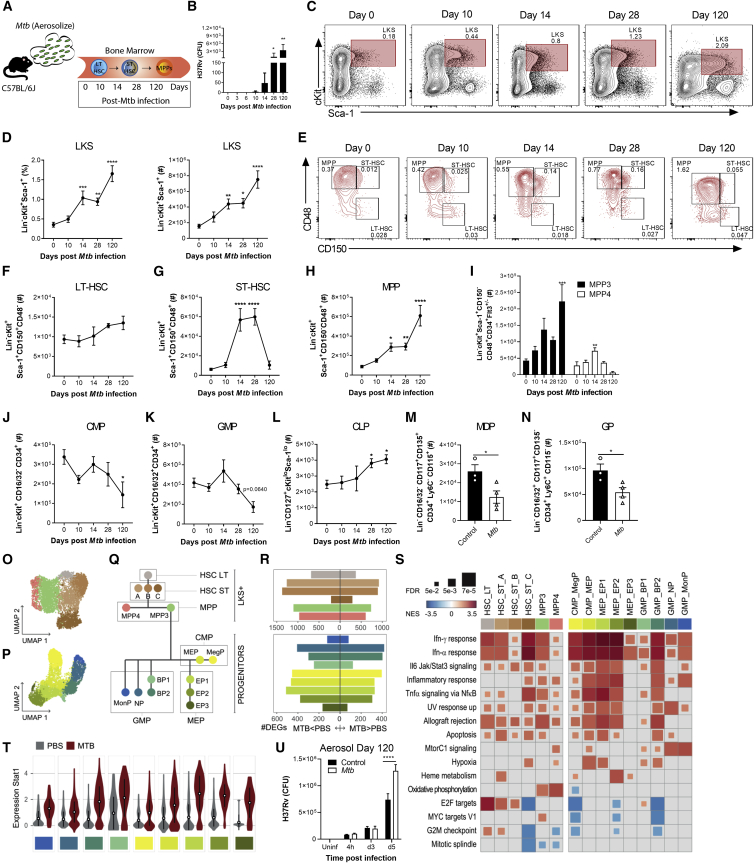
Aerosolized Mtb Disseminates to the BM and Expands LKS Cells(A) Aerosol model used in (B)–(U).(B) BM CFUs.(C and D) Representative FACS plots of LKS cells as quantified in (D) as frequency (left) and total number (right).(E–I) Representative FACS plots (E) of LT-HSCs (F), ST-HSCs (G), MPPs (H), and MPP3/4 (I) (n = 4–10 mice/group).(J–N) Total CMPs (J), GMPs (K), and CLPs (L) (n = 4–8 mice/group) and MDPs (M) and GPs (N) on day 120.(O and P) UMAP dimensionality reduction plots for LKS+ (O) and cKit+ (P) cells.(Q) Hematopoietic tree with approximate position of the different clusters identified (color code in common with O and P).(R) Number of genes up- and downregulated in each cluster (abs(logFC) > 0.1 and FDR < 0.05).(S) GSEA of genes ranked according to Mtb effects in each cluster.(T) Stat1 expression across clusters.(U) BMDMs from mice infected with Mtb for 120 days were infected in vitro and CFU quantified (n = 3 mice/group).One-way ANOVA followed by Tukey’s multiple comparisons test (B, D, and F–L), two-tailed Student’s t test (M and N), and two-way ANOVA followed by Sidak’s multiple comparisons test (U) were used. Data are representative of two (B and J–N) or three (C–I) independent experiments. See also Figure S3.